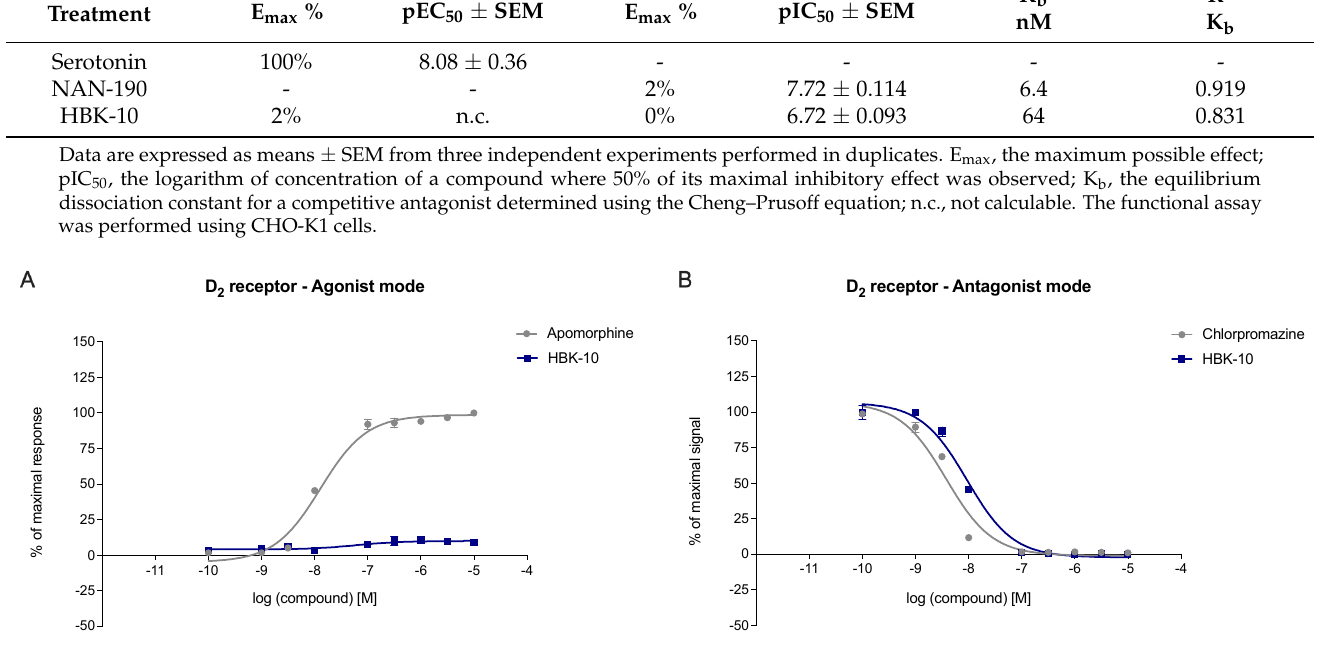
Figure 3. The activity of HBK-10 at D 2 receptors in in vitro functional assays (agonist mode: Panel ( A ); antagonist mode: Panel ( B )). Graphs represent dose–response curves for functional activity of the compound in calcium mobilization assay. Table 5. Intrinsic activity of HBK-10 at the dopamine D 2